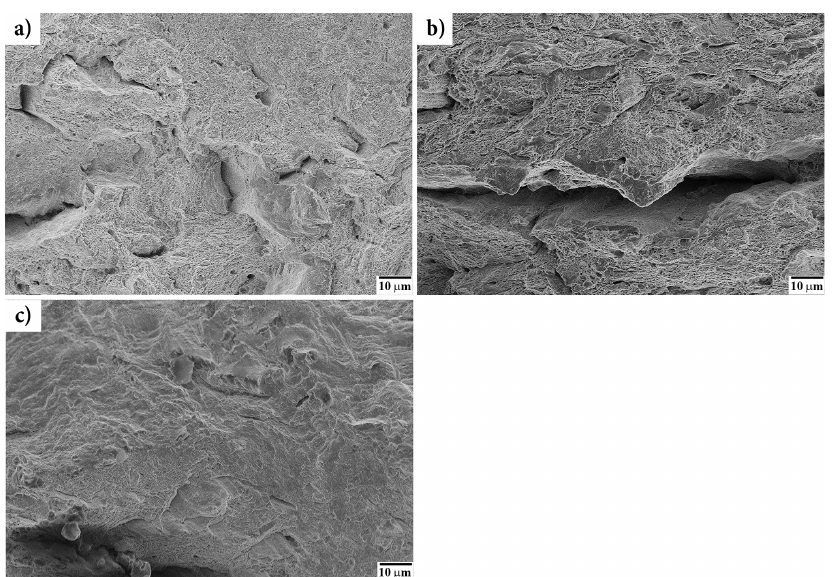
Figure 6: Fracture features of tensile- tested T92 steel samples solutionized at 1,100°C and tempered at (a) 730°C, (b) 745°C and (c) 760°C.